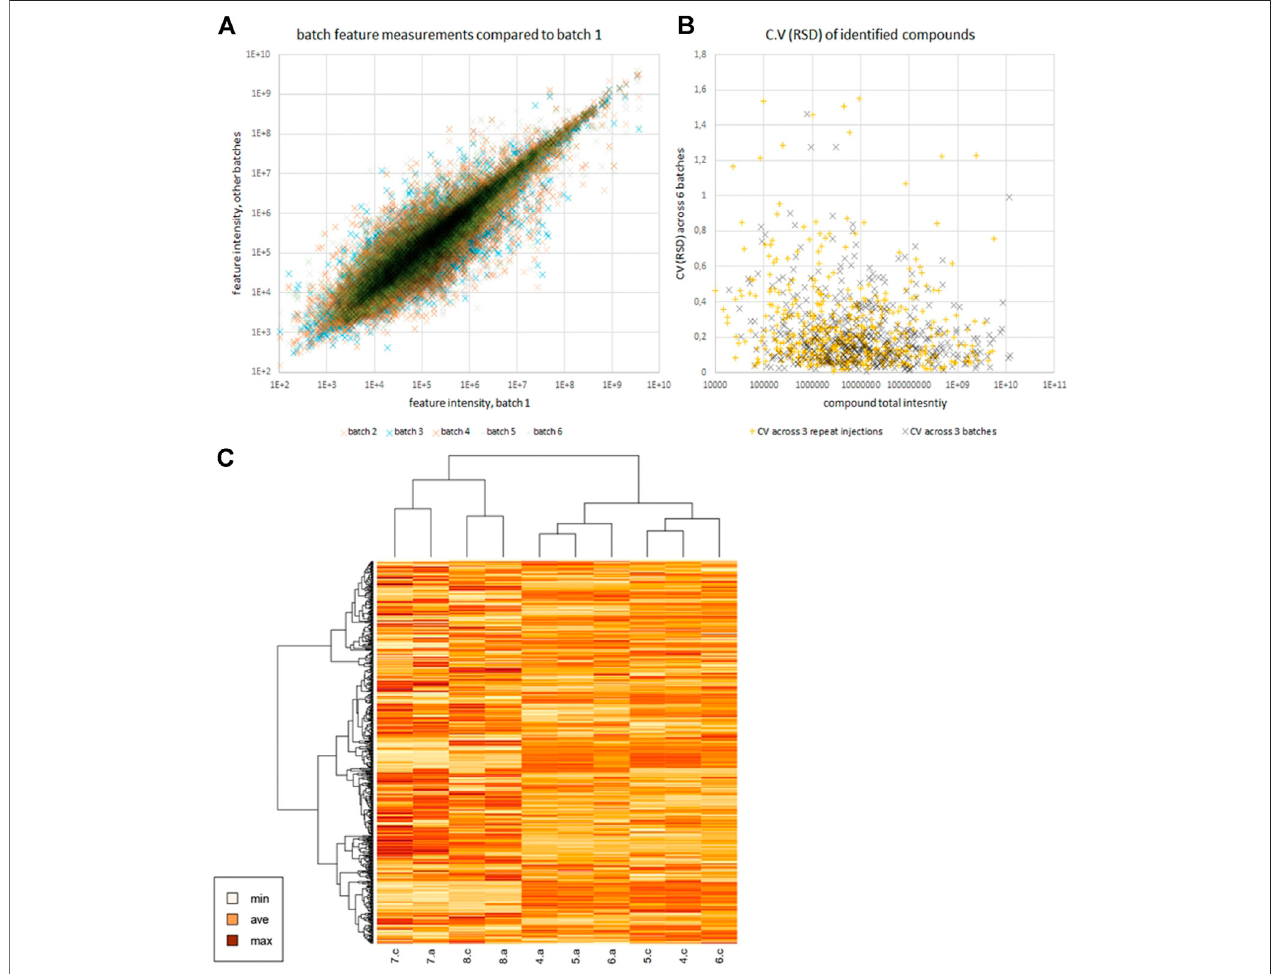
FIGURE 2 | Panel (A) shows scatter plot of feature intensities of batches 2 – 6 vs batch 1, illustrating the reproducibility between batches. Panel (B) compares the CVs (RSDs) of identi fi ed compounds across repeat injections and across batches. Panel (C) is a heatmap generated in R version 4.0.0 (April 24, 2020) of scaled log intensity reported by Compound Discoverer for those compounds identi fi ed (mostly small molecules, not peptides). Compounds with multiple features were summed ( Supplementary Table S3 ). Technical repeats, a and c are shown for N2-01 batches 4, 5 and 6, alongside 7 and 8 which are octopus and squid